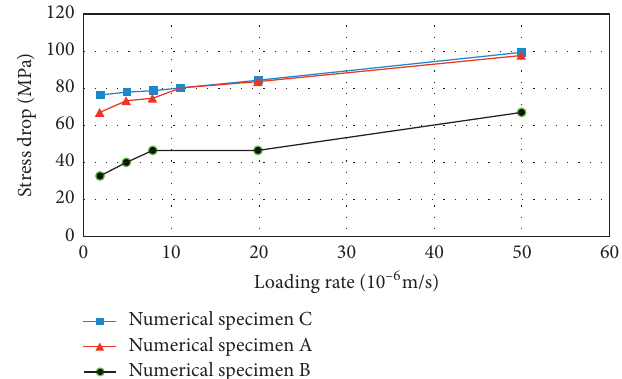
Figure 7: Relationship curve between stress drop and loading